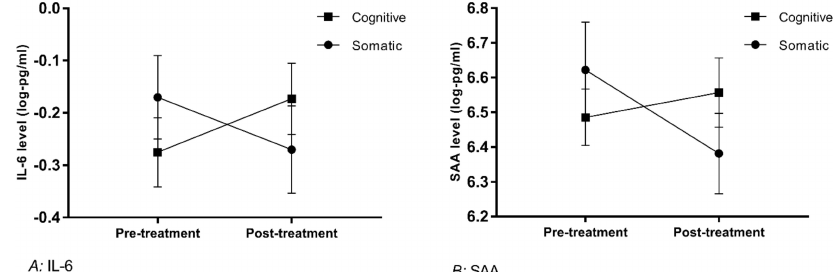
Figure 2. IL-6 and serum amyloid alpha (SAA) changes with therapy in somatic vs. cognitive symptom